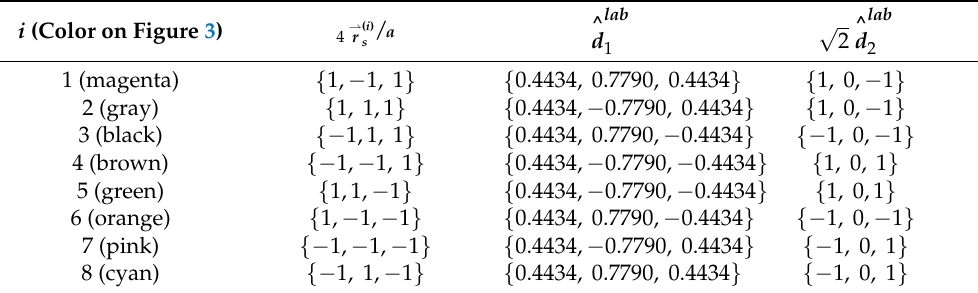
( i ) Table 2. Coordinates of the centers r s of hexagons within the unit cell with a side length a , unit (cid:42) (cid:42) d 1 and d 2 (see Figure 2) given in the laboratory vectors ˆ d lab and ˆ d lab along the direction of vectors 2 1 coordinate system ( x , y , z ) (Figure